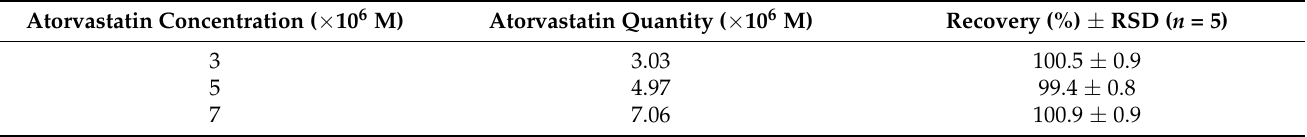
Table 7. Recovery test at atorvastatin